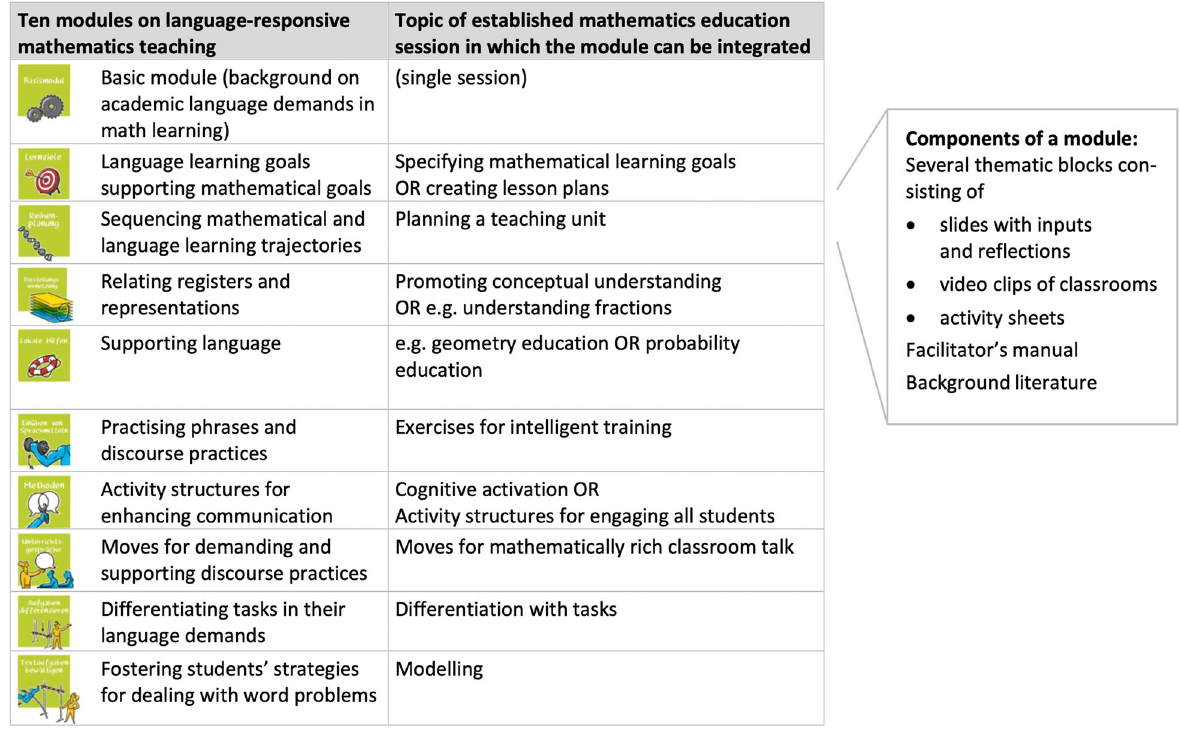
Fig. 3 Overview on ten modules on language-responsive mathematics